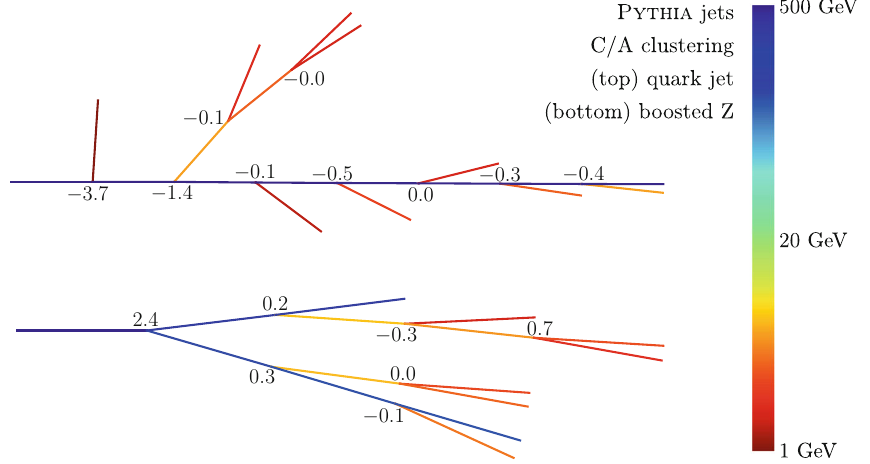
Fig. 13 Junipr trees for visualization of discrimination power at indi- using Pythia , with mass between between 90.7 and 91.7 GeV; the bot- tomfigureisaboosted- Z jet.Therolethattheenergydistribution,open- vidual nodes in the clustering history. Each node is labeled with the (cid:15) P q ( jet ) associated with that t step. Col- ingangles,multiplicity,andbranchingpatternplayinhigh-performance component of log 10 P Z ( jet ) discrimination can be understood from such ors represent energies, and opening angles represent physical three- dimensional branching angles. The top figure is a quark jet generated